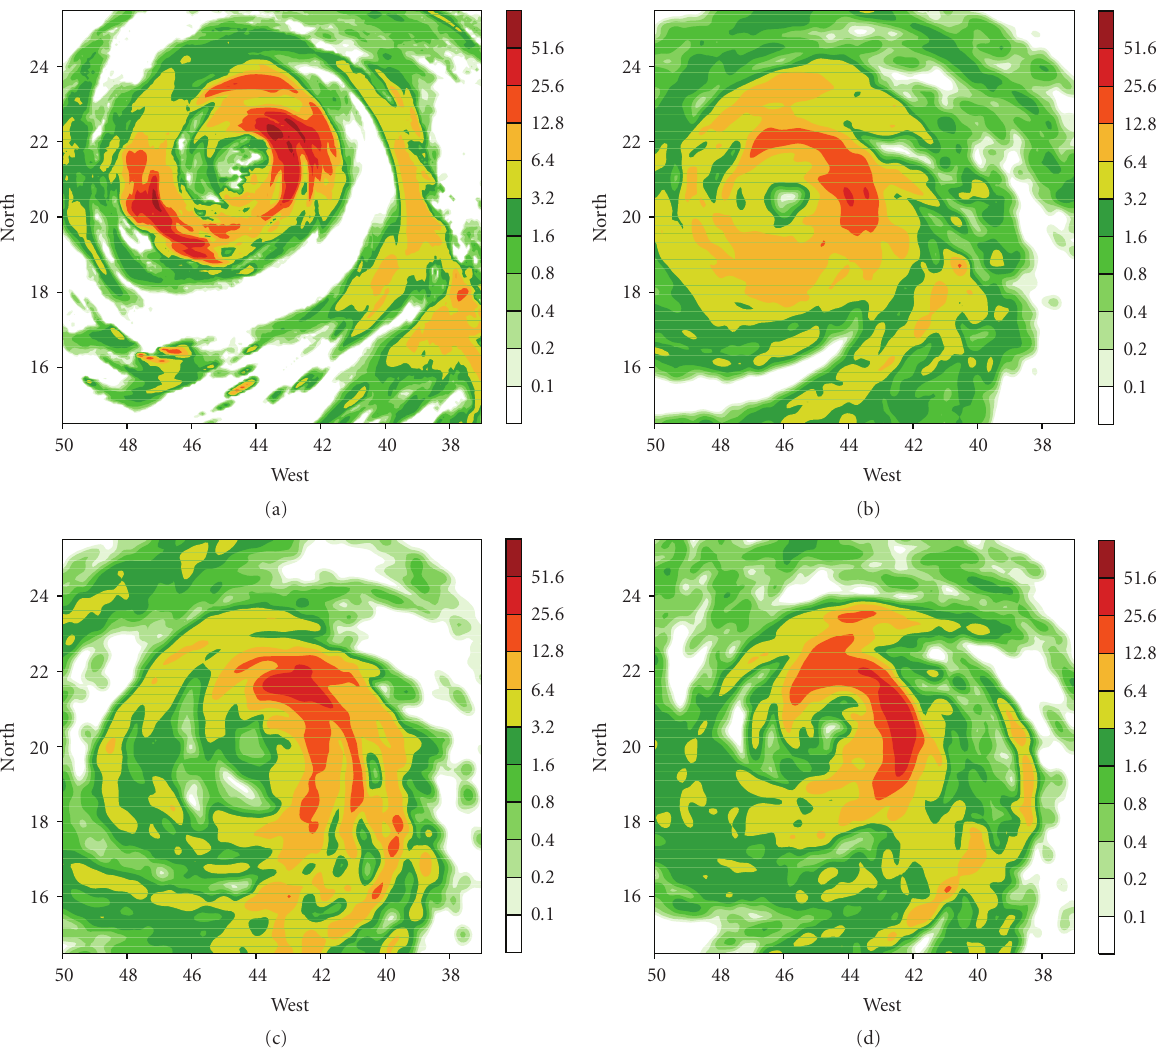
Figure 10: The simulated accumulated 3 hours rainfall (mm) from (a) regional nature run, (b) control run, (c) data assimilation Experiment 1, and (d) data assimilation Experiment 2 at 1800 UTC 02 October 2005.